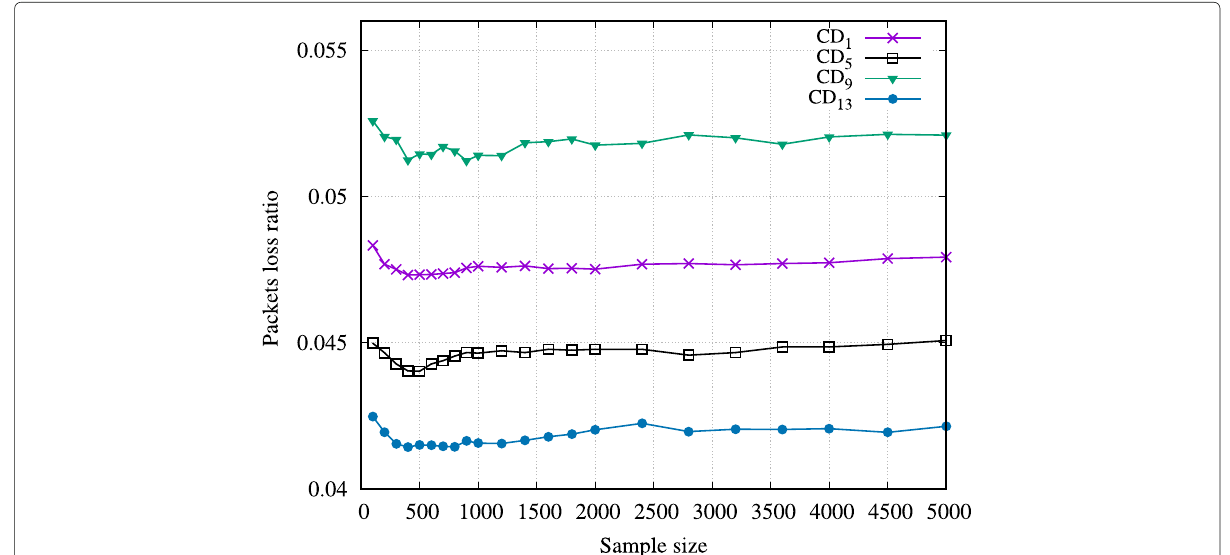
Fig. 10 Packet loss ratio vs. sample size in DSS-TA: superframe = 70 ms, Tx power = –15